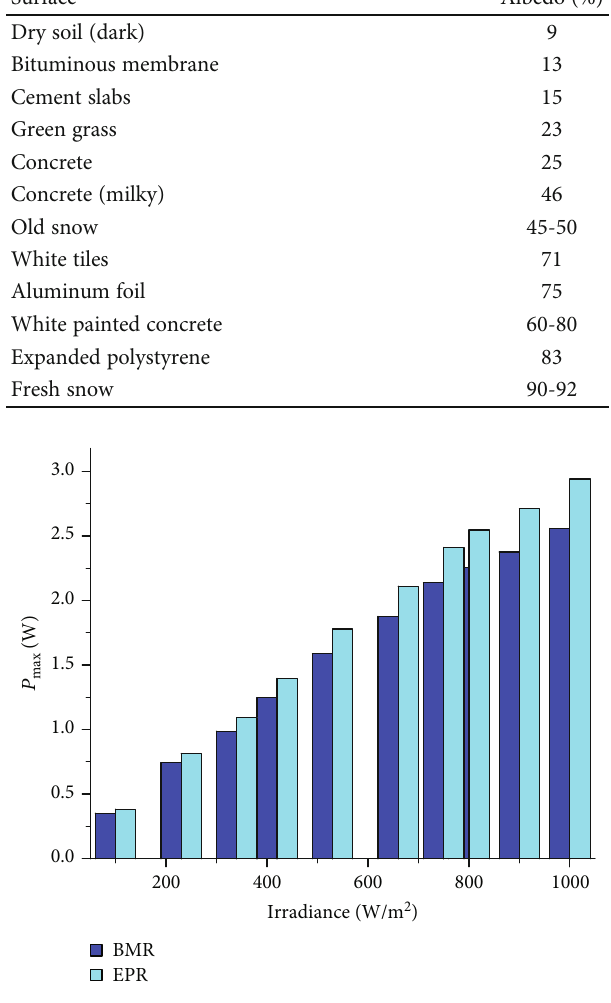
Figure 3: P max generated by the two PV panels.